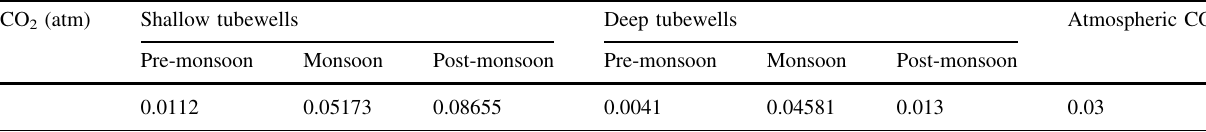
Table 3 Partial pressure of CO 2 (determine by Aquachem Software) PCO 2